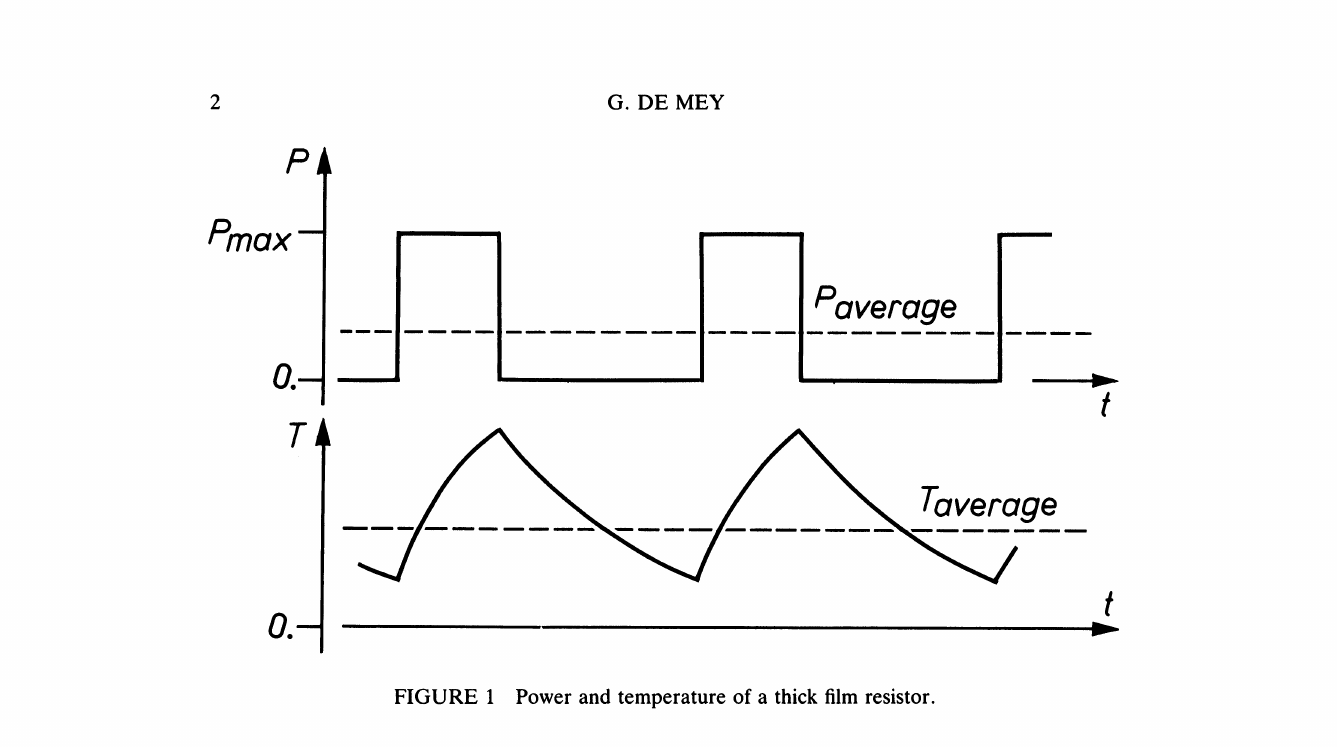
FIGURE Power and temperature of a thick film